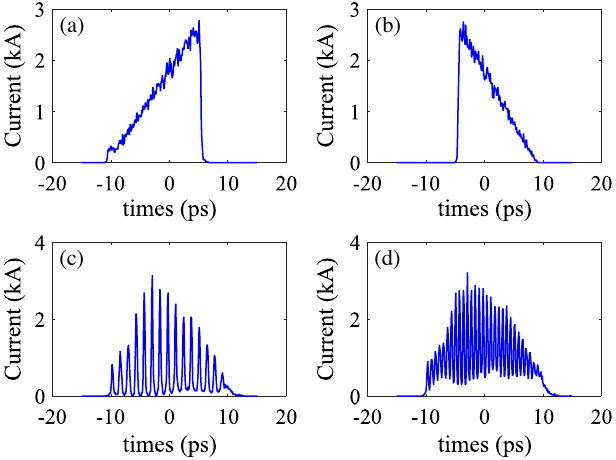
FIG. 6. Start-to-end simulation results for arbitrary shaping using a 60-nC bunch. Each panel shows the longitudinal profile after shaping: (a) doorstep, (b) reverse triangle, (c) comblike bunch, and (d) comblike bunch with a higher frequency. The transmitted charges are 22, 18, 12, and 23 nC, respectively. Negative time corresponds to the head of the